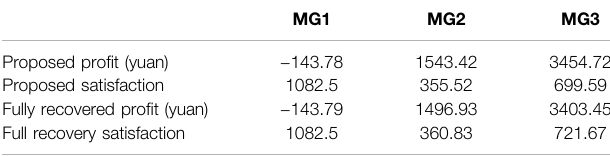
TABLE 3 | Comparison of satisfaction and pro fi t between MGs.